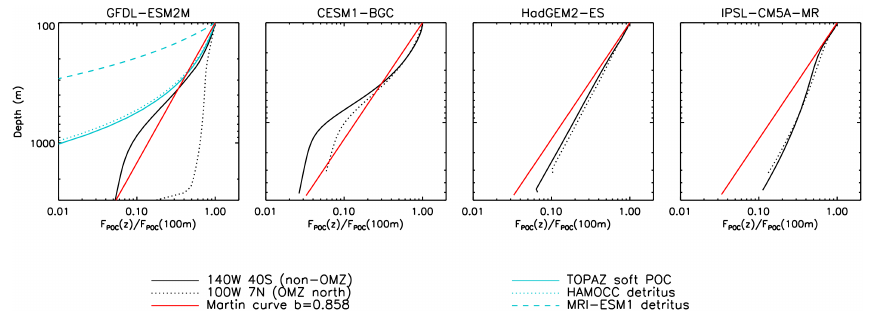
Figure 6. POC flux profile normalized to the value at 100m in the four CMIP5 models that provided three-dimensional data: (a) GFDL- ESM2M, (b) CESM1-BGC, (c) HadGEM2-ES, and (d) IPSL-CM5A-MR. The depth profile is shown for two locations, a typical non-OMZ region at 40 ◦ S (solid black) and a typical OMZ (dashed black). The red line in each panel is a power law with exponent 0.858 (Martin et al., 1987). Note that GFDL-ESM2M and CESM1-BGC POC flux profiles are modelled as exponential curves, while IPSL-CM5A-MR and HadGEM2-ES profiles are modelled as power laws (see equations in Table A3). In panel (a) , we also show the transfer efficiency for the exponential soft POC remineralization flux in TOPAZ2 (GFDL-ESM2 models), HAMOCC (NorESM1-ME and MPI-ESM models), and MRI-ESM1, all of them modelled as